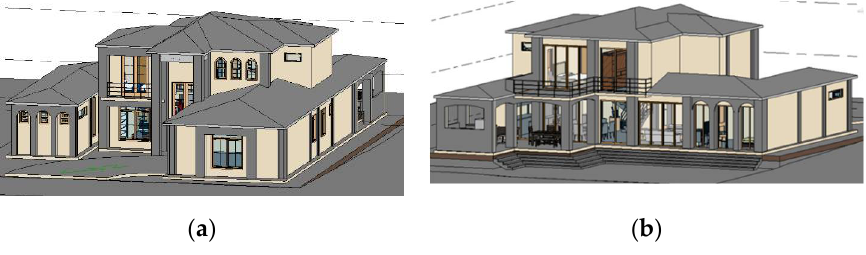
Figure 3. Views of the house. ( a ) front view; ( b ) rearview.